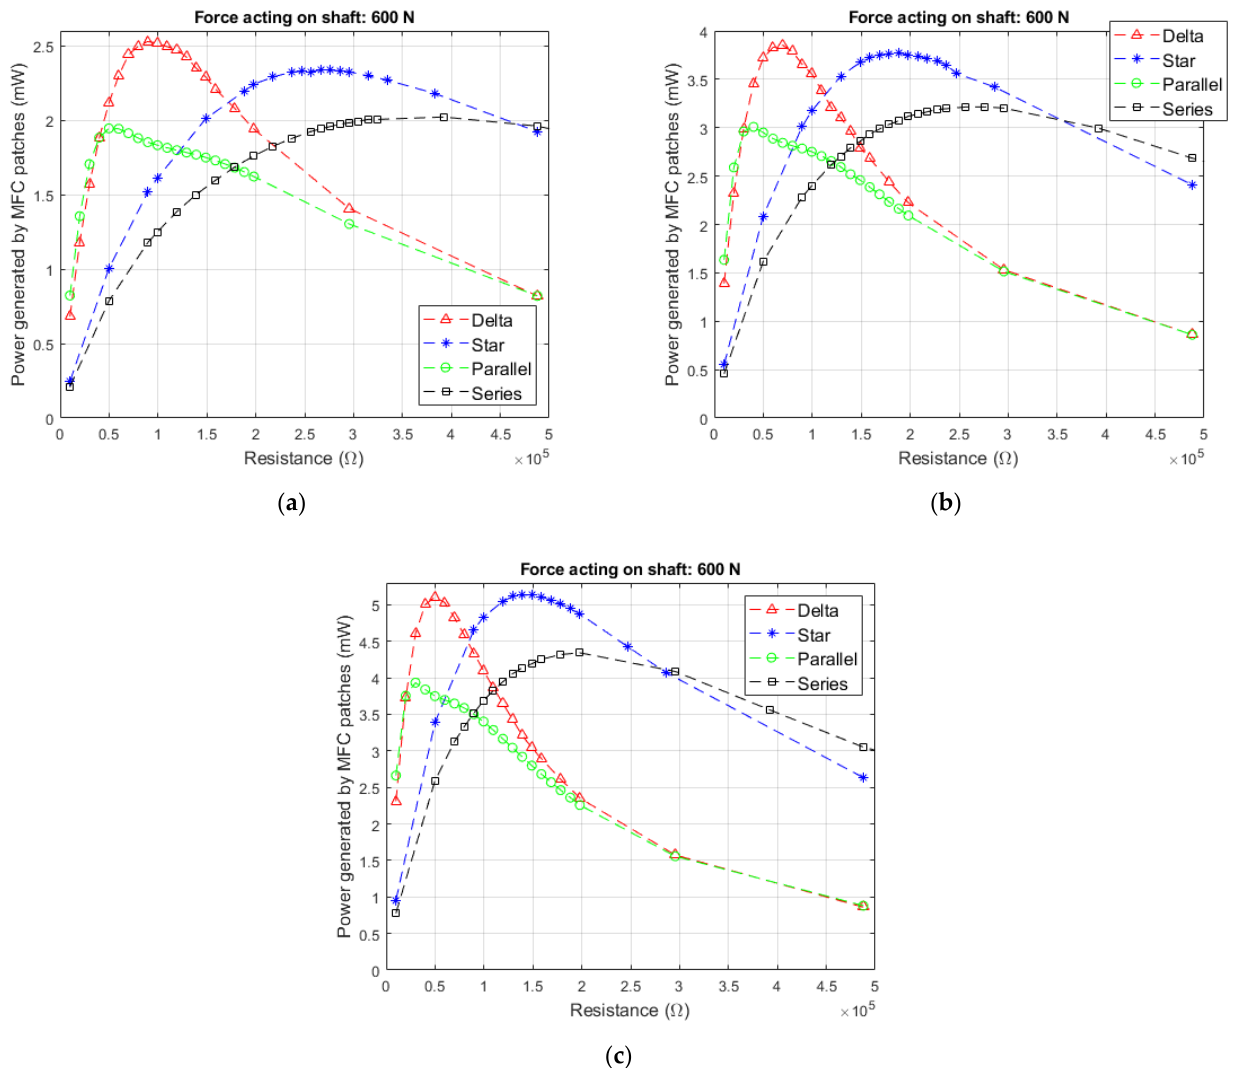
Figure 10. Electrical power generated for a force equal to 600 N: ( a ) rotational speed equal to 10 rps; ( b ) rotational speed equal to 15 rps; and ( c ) rotational speed equal to 20 rps.